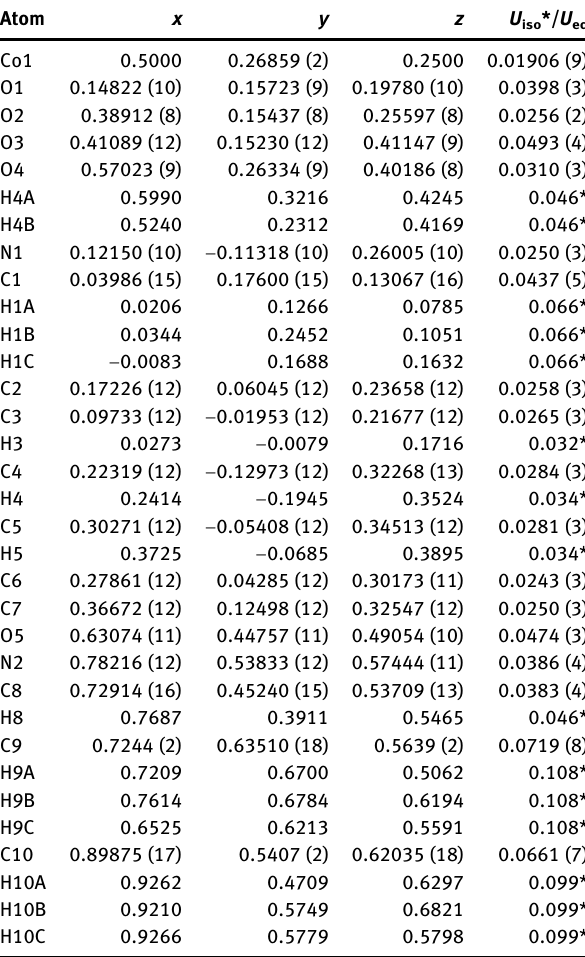
Table  : Fractional atomic coordinates and isotropic or equivalent isotropic displacement parameters (Å 